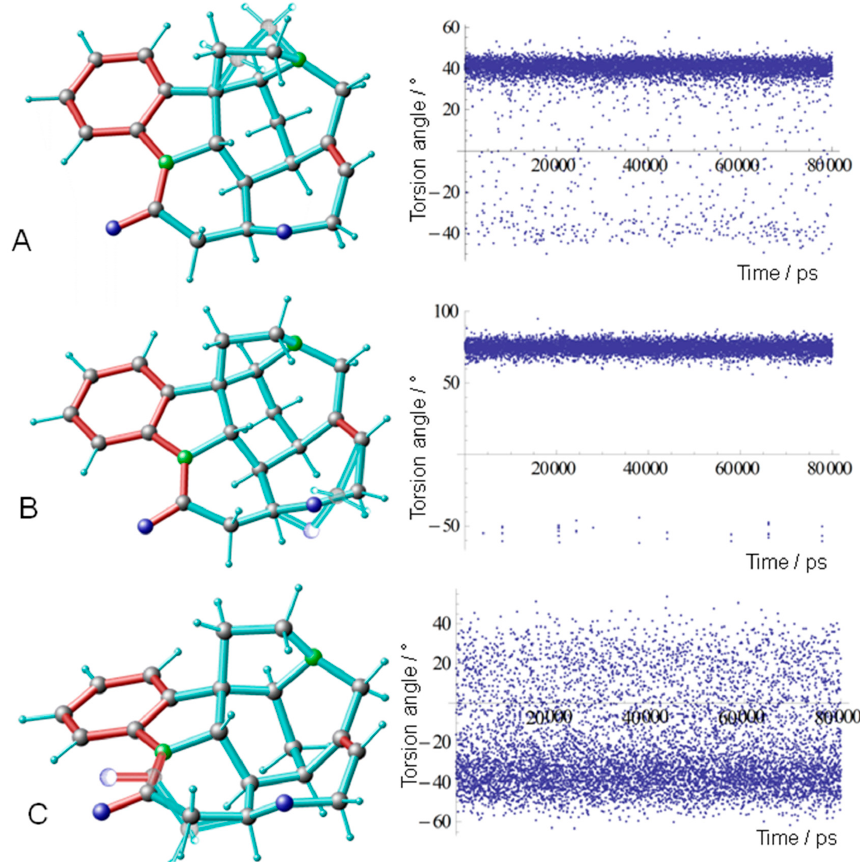
Figure 2. Torsion angle trajectories of the C, F, and G rings. ( A ) Torsion trajectory of the C ring C7-C17-C18-N17 with the major conformation of the C ring 1c1 around 40° and the minor conformation 1c2 around − 40°. The minor conformation 1c2 is displayed transparently within the molecular scheme on the left side. ( B ) Torsion trajectory F ring C12-O24-C23-C22 with the major conformation of the ring 1f1 around 75° and the minor conformation 1f2 around − 50°. ( C ) Torsion trajectory G ring N9-C10-C11-C12 with the major conformation of the ring 1g1 around − 40° and the minor conformation 1g2 in the range between 0 and 50°.